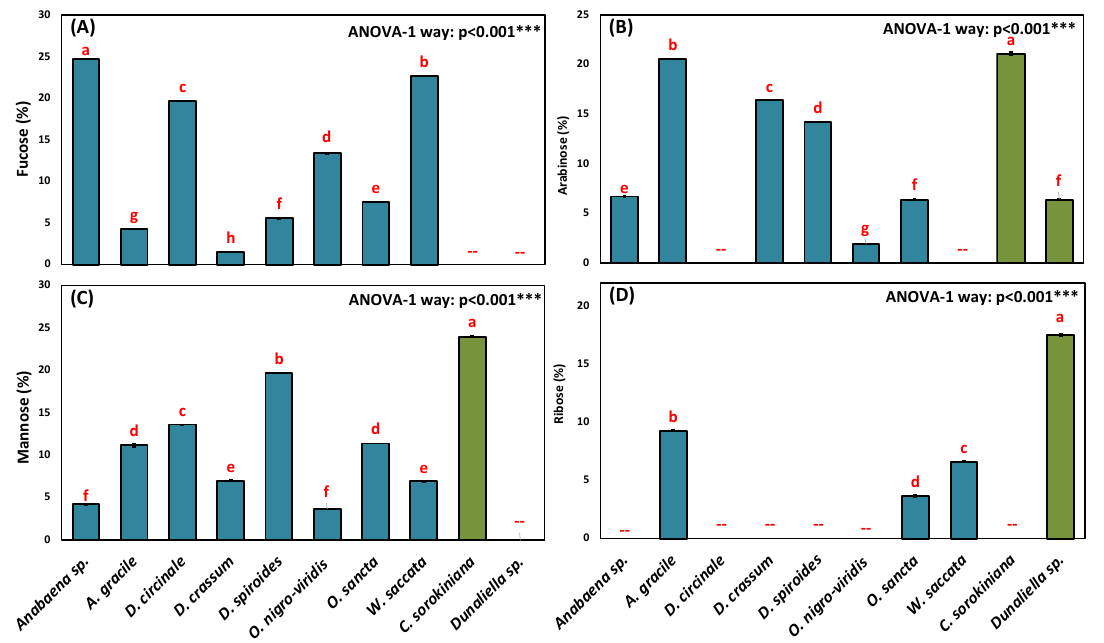
Figure 5. The monosaccharide compositions (%) isolated from the hydrolyzed exopolysaccharides in the different cyanobacterial and algal strains studied: ( A ) fucose, ( B ) arabinose, ( C ) mannose, and ( D ) ribose. Bars with different superscript letters were significantly different according to DMRT at p < 0.05. *** significant at p < 0.001.